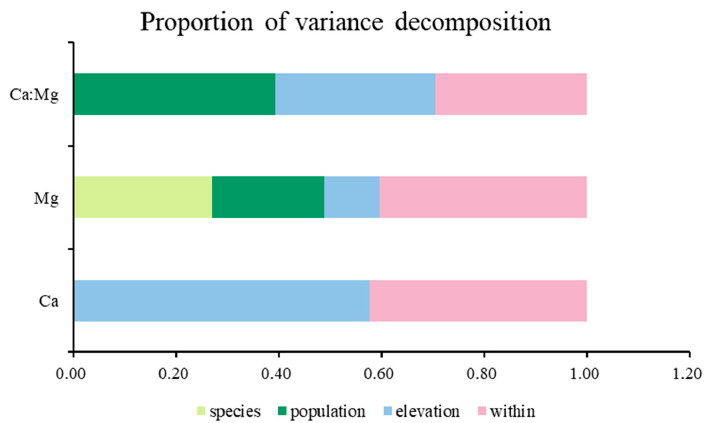
Figure 1. Proportion of variance decomposition. Different color block length represents the inter- pretation rate of different factors to variation of traits. Vertical axis represents different traits, and horizontal axis represents different proportion.